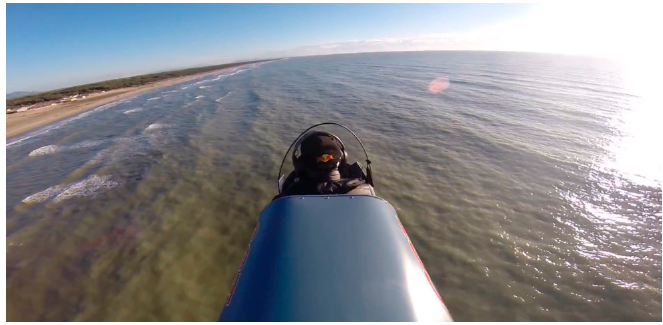
Figure 4. A typical situation of flight over the sea with the Radgyro.